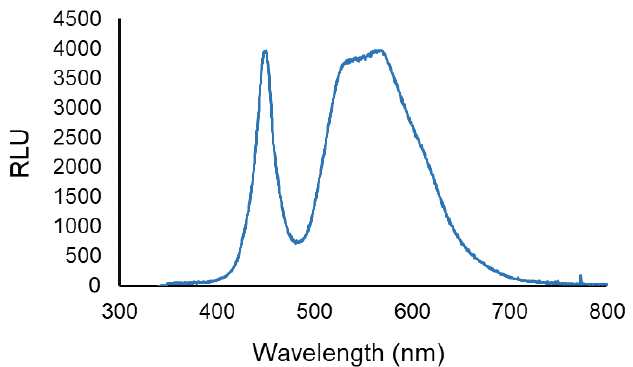
Figure 2. LED output. The spectral range of the white light emitted by the LED projector used. Data are shown as relative light units vs. wavelength.